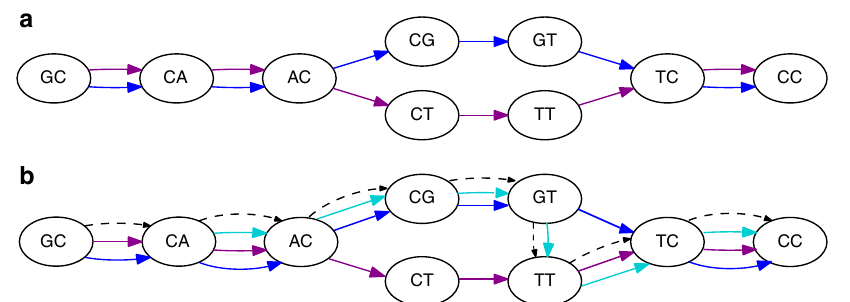
Fig. 1 The de Bruijn graph and an example of a collinear block. a The graph built from strings “ GCACGTCC ” and “ GCACTTCC ” , with k = 2. The two strings are re fl ected by the blue and magenta walks, respectively. This is an example of a collinear block from two walks. There are four bubbles. The bubble formed by vertices “ AC ” and “ TC ” describes a substitution within the block, while three other bubbles are formed by parallel edges. The blue and magenta walk form a chain of four consecutive bubbles. b An example of a more complex block, where we have added a third sequence “ CACGTTCC ” (turquoise) to the input. We can no longer describe the block as a chain of bubbles, as they overlap to form tangled structures. Instead, we consider the path in the graph (dashed black) that shares many vertices with the three collinear walks. This carrying path shares many vertices with the three extant walks, and each walk forms its own chain with it. The task of fi nding good collinear blocks can then be framed as fi nding carrying paths that form good chains with the